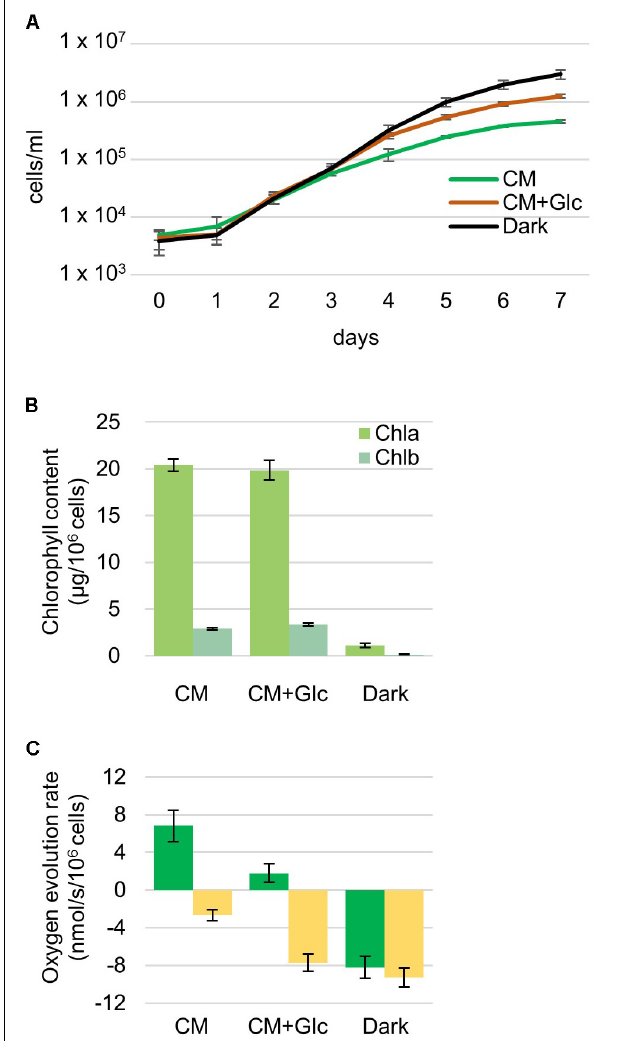
FIGURE 1 | Properties of Euglena cells grown under photoautotrophic, photomixotrophic and heterotrophic conditions. (A) Growth curve of the cells. Algal cultures were diluted with fresh medium at an initial cell number approximately 4,000 and grown for 7 days. Error bars indicate the SE based on six independent experiments. (B) Chlorophyll contents per 10 6 cells. Error bars indicate the SE based on at least twelve independent experiments. (C) Oxygen evolution and consumption rates. Oxygen evolution rates were measured under the growth light intensity (105 µ mol photons m − 2 · s − 1 ). Green bar: oxygen evolution rate, yellow bar: oxygen consumption rate. Error bars indicate the SE based on at least three independent